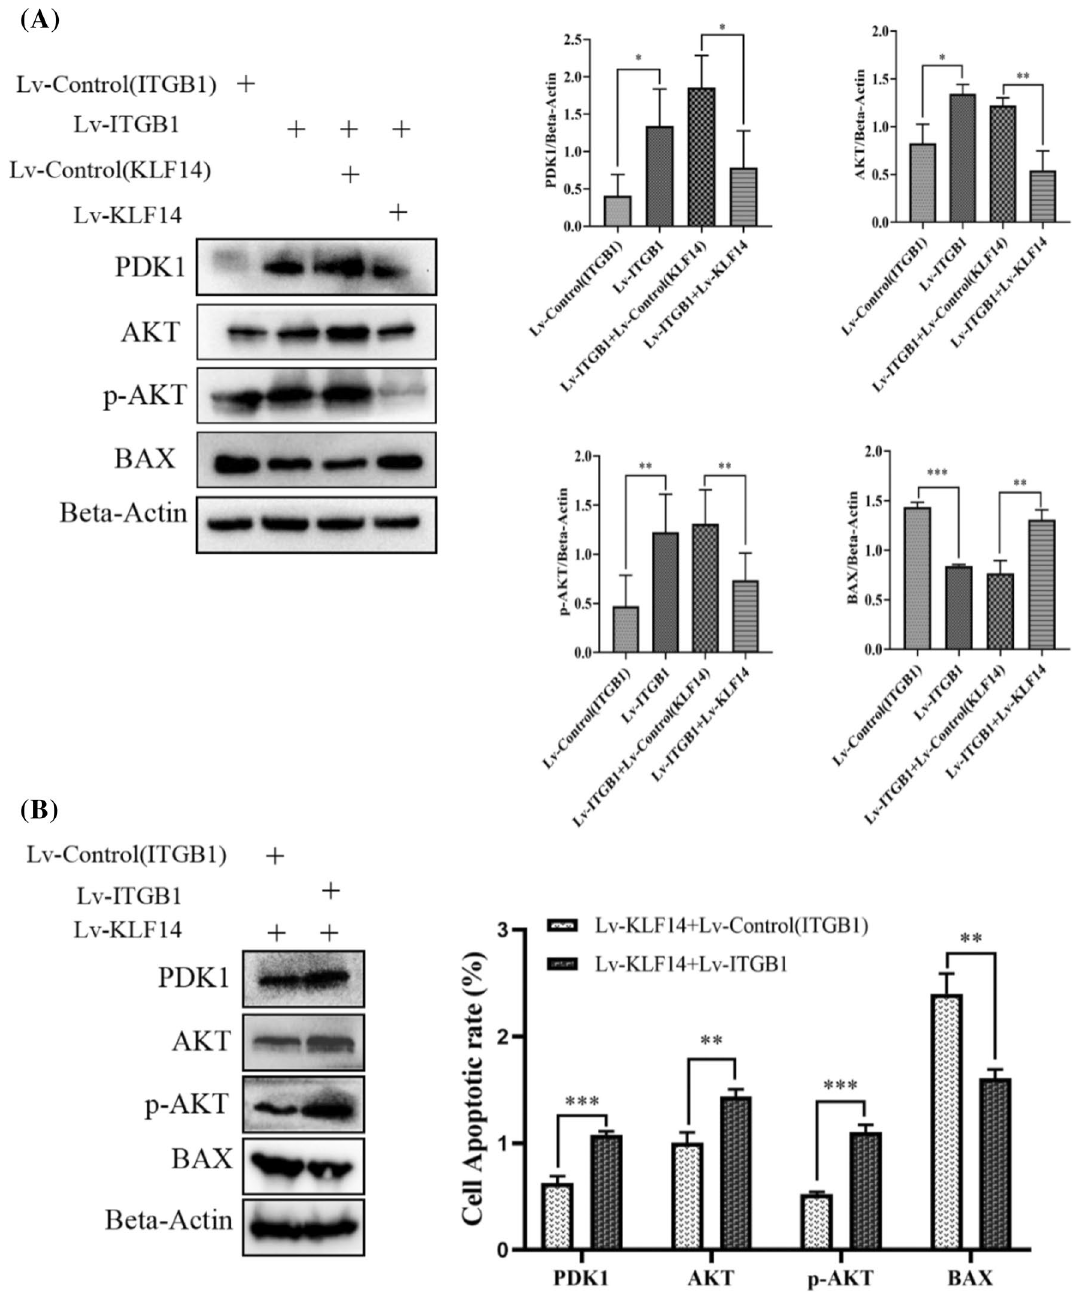
Fig. 7 KLF14 targets ITGB1 and inhibits the development of cervical cancer through the PI3K/AKT signalling pathway. A Four groups were established: Lv-control (ITGB1), Lv-ITGB1, Lv-ITGB1 + Lv-control (KLF14) and Lv-ITGB1 + Lv-KLF14 (the KLF14 overexpression lentivirus and its negative control lentivirus were transfected into SiHa cells transfected with Lv-ITGB1). When ITGB1 was overexpressed, compared to the Lv-control (ITGB1) group, the Western blot results showed that the expression of PDK1, AKT and p-AKT was upregulated, while Bax was downregulated. However, when Lv-KLF14 and Lv-ITGB1 were cotransfected, the expression of PDK1, AKT and p-AKT was downregulated compared to that in the Lv-ITGB1 + Lv-control (KLF14) group, while Bax was upregulated. B. Two groups were established: Lv-KLF14 + Lv-con- trol (ITGB1) and Lv-KLF14 + Lv-ITGB1 (the ITGB1 overexpression lentivirus and its negative control lentivirus were transfected into SiHa cells transfected with Lv-KLF14). For Lv-KLF14 + Lv-control (ITGB1) and Lv-KLF14 + Lv-ITGB1, the Western blot results showed that the expression of PDK1, AKT and p-AKT in the Lv-KLF14 + Lv-ITGB1 group was upregulated compared to that in the Lv-KLF14 + Lv-control (ITGB1) group, while Bax was downregulated. (*P < 0.05, **P < 0.01, ***P <